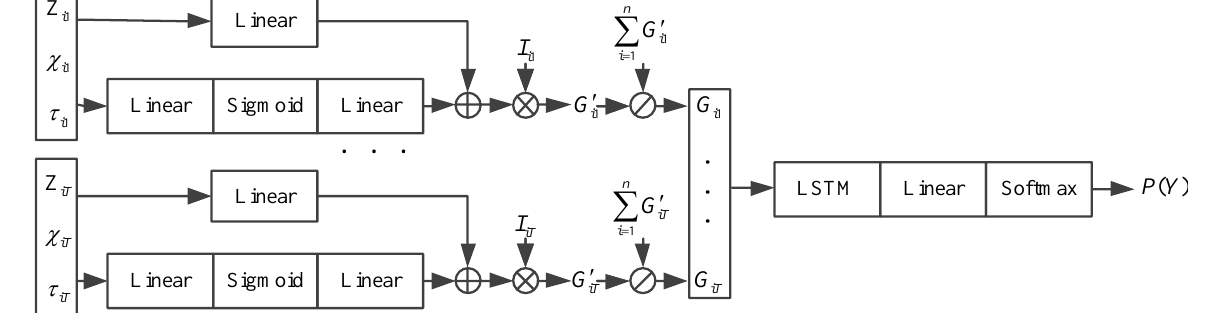
Figure 9. Design of intention inference network.